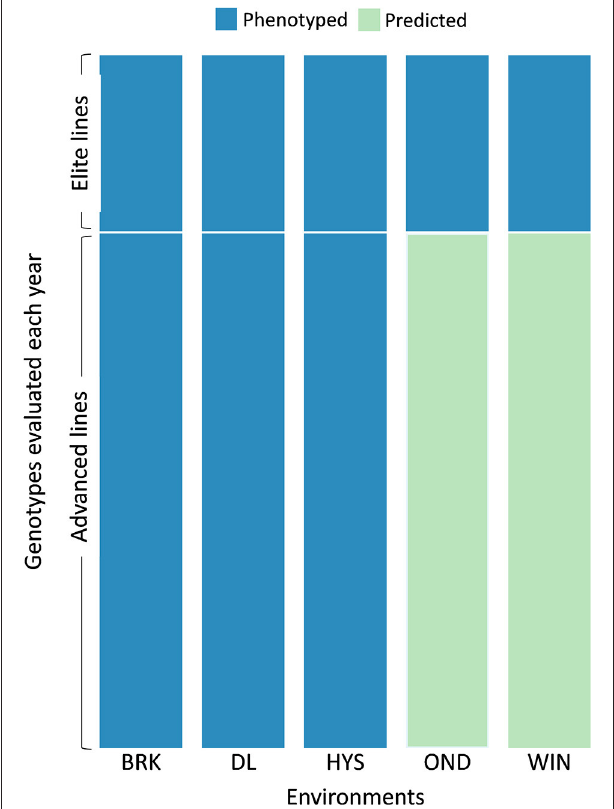
FIGURE 5 | Testing design for the independent prediction of agronomic traits using the MTME model. Each year, a set of elite and advanced lines is evaluated over multiple locations. The sparse testing design proposes phenotyping of elite lines in all the environments (five in this scenario) and advanced lines in fewer environments (three in this scenario). For independent prediction, the dataset from 2018–19 comprised 55 elite lines with checks and 96 advanced lines. The 2019–20 dataset comprised 42 elite lines with checks and 114 advanced lines. Five environments: BRK, Brookings; DL,